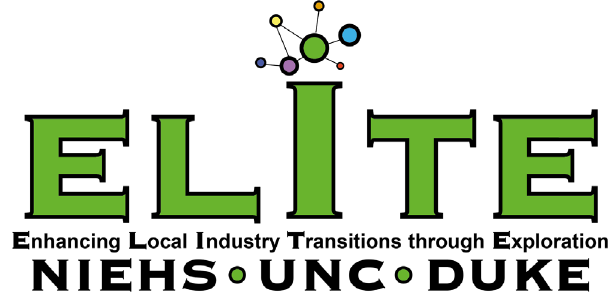
Figure 3. ELITE Consortium branding logo. We developed a unique logo for the program to ensure consistency in messaging, and to make the program easily recognizable when distributing marketing materials.